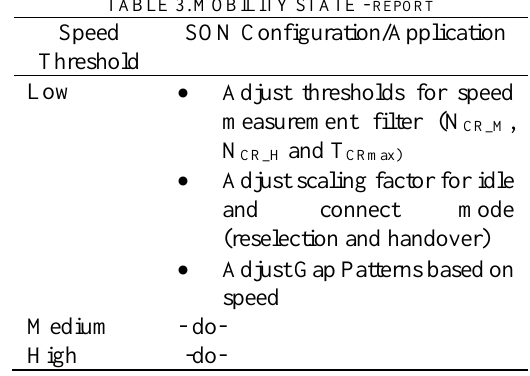
TABLE 3. MOBILITY STATE -